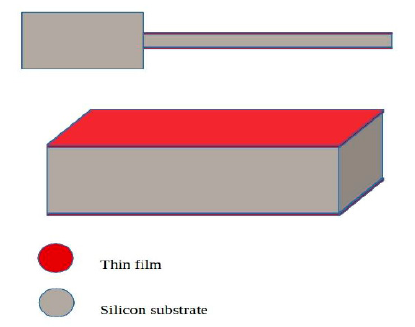
Figure 1. Aluminum film deposited on a silicon substrate. The film thickness on each side ranges from 0.1 µm to 4 µm while the silicon substrate is 56 µm.